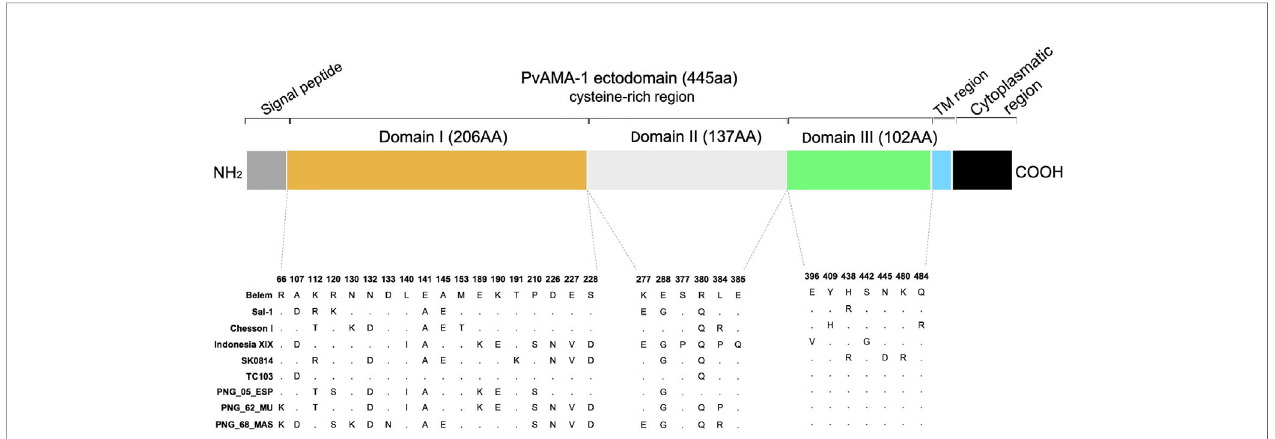
FIGURE 2 | Schematic structure of PvAMA-1 and polymorphism display in comparison to the Belem variant. Signal peptide (gray), the ectodomain comprised domain I (yellow), domain II (light gray) and domain III (green), transmembrane region (blue) and cytoplasmic region (black). The polymorphic sites across the isolates are represented by amino acid letters, and the dots represent the nonpolymorphic